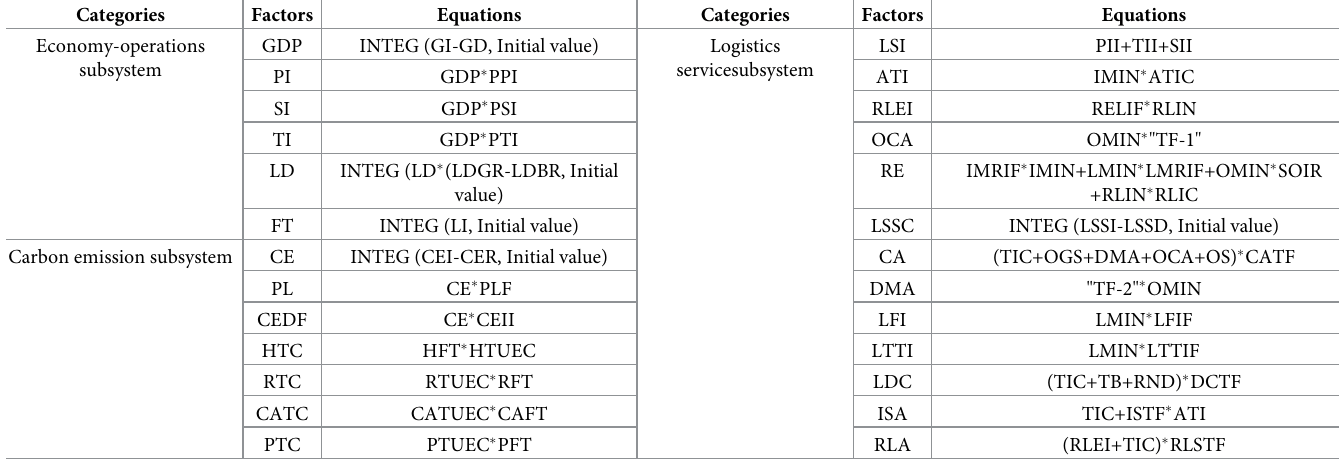
Table 4. Main factors and equations of stock-flow